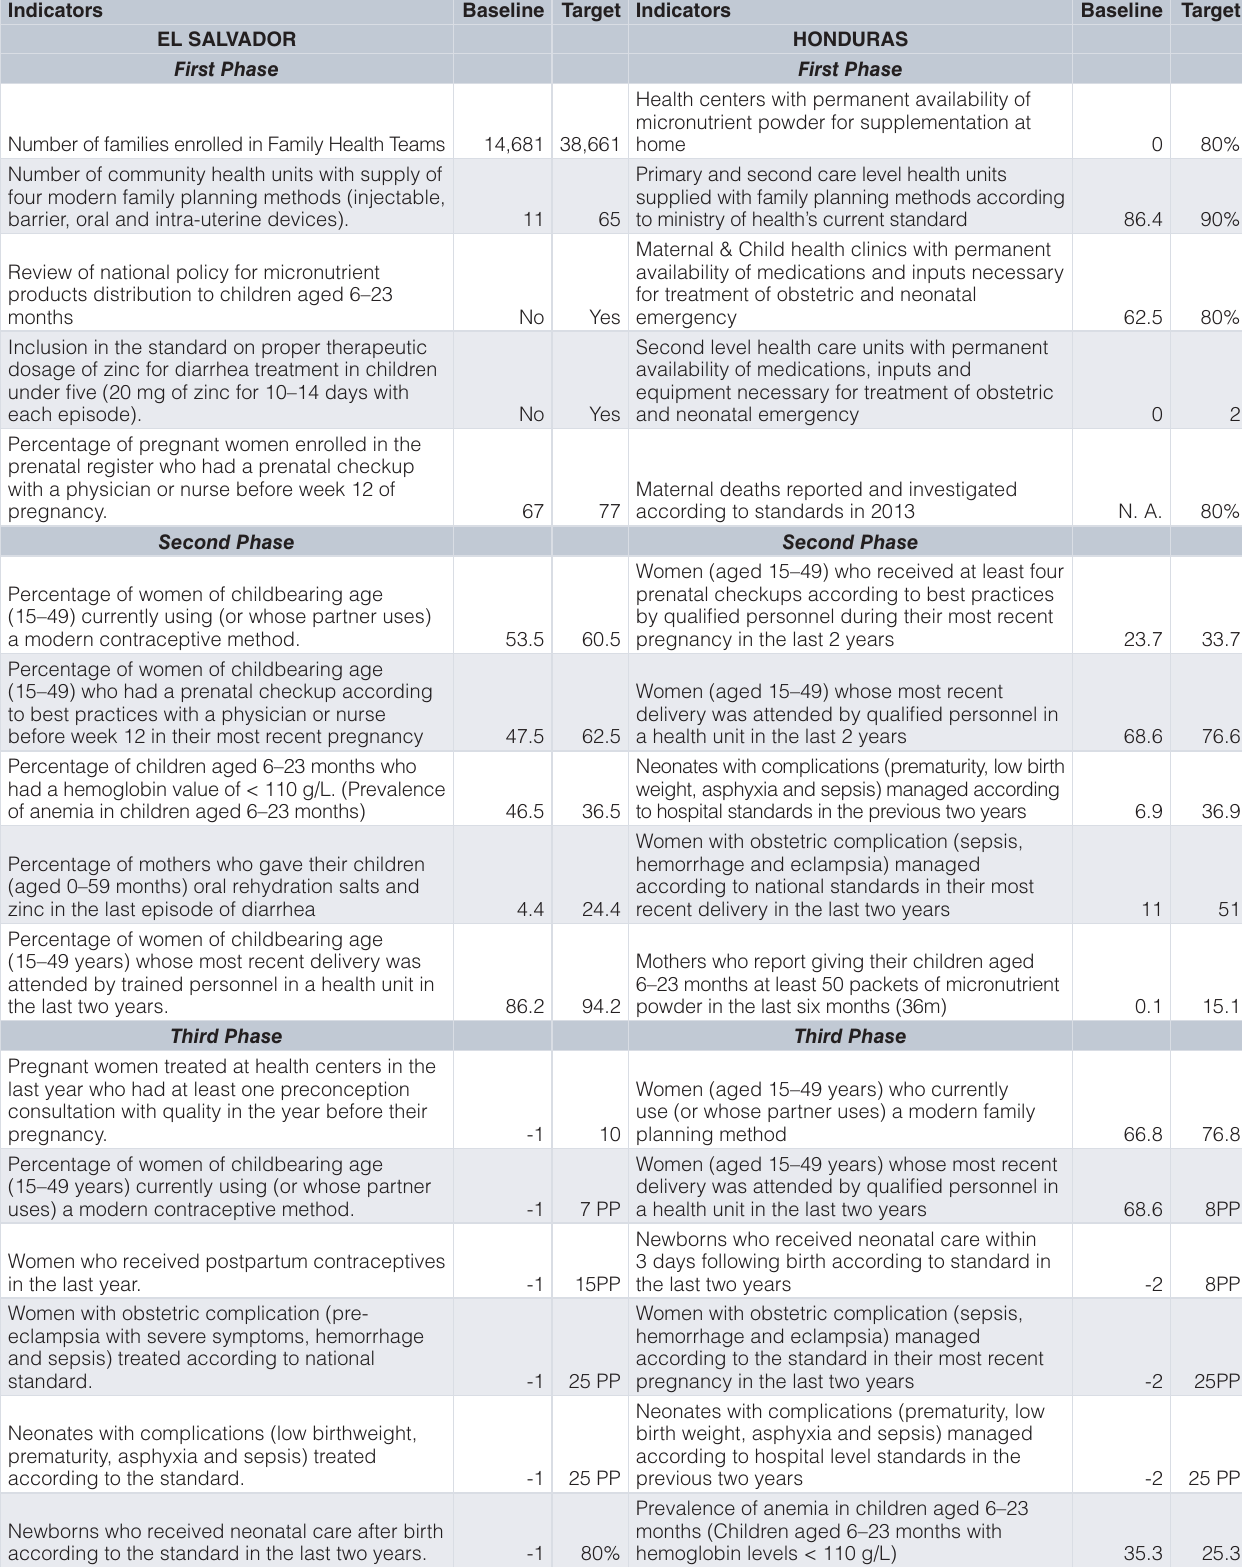
Table 2. Summary of performance frameworks in El Salvador and